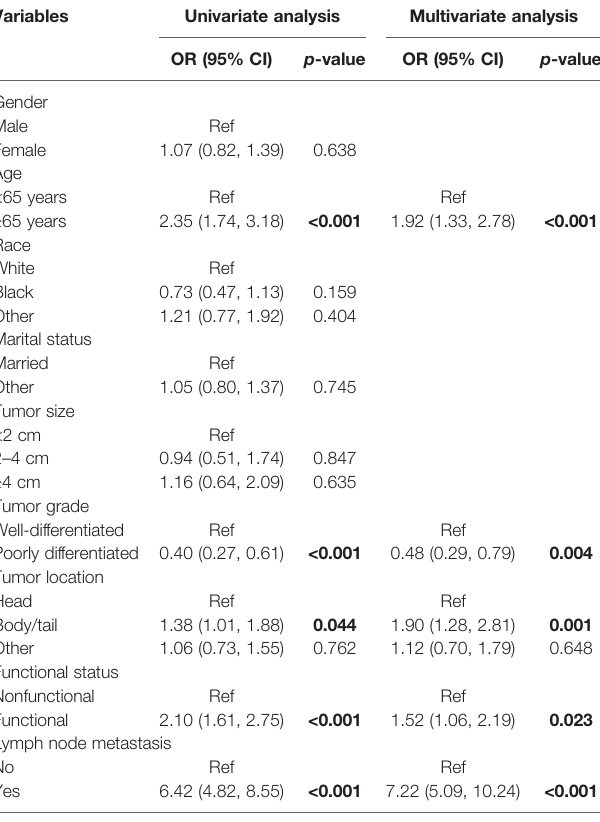
TABLE 4 | Factors associated with PanNET patients who underwent CDS in the SEER database.